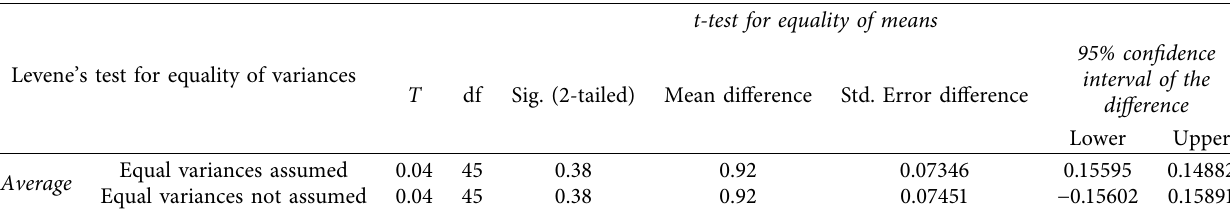
Table 5: T -test for independent samples for the pretest scores of EG and CG.